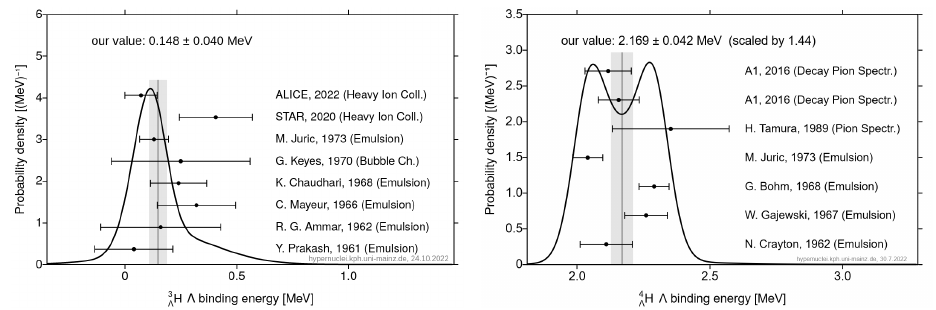
Figure 1. Ideograms of the world data sets on Λ binding energy measurements for 3 Λ H (left) and 4 Λ H (right) [5]. The error bars include statistical and systematic uncertainties. In case of 4 Λ H , the data have (cid:112) χ 2 / ndf and multiplying it with the been conservatively handled by computing a scaling factor S = error. Our averages are B Λ ( 3 Λ H) = 0 . 148 ± 0 . 040MeV and B Λ ( 4 Λ H) = 2 . 169 ± 0 .